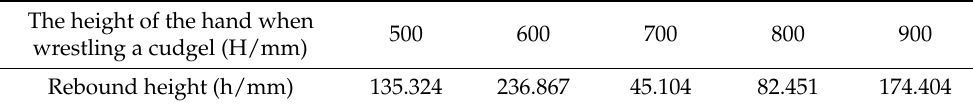
Figure 7. The maximum displacement cloud map of the rebound after the cudgel was wrestled simulated by ABAQUS. Table 2. The height of the hand corresponding to the height of the rebound at the node of the rod tip.